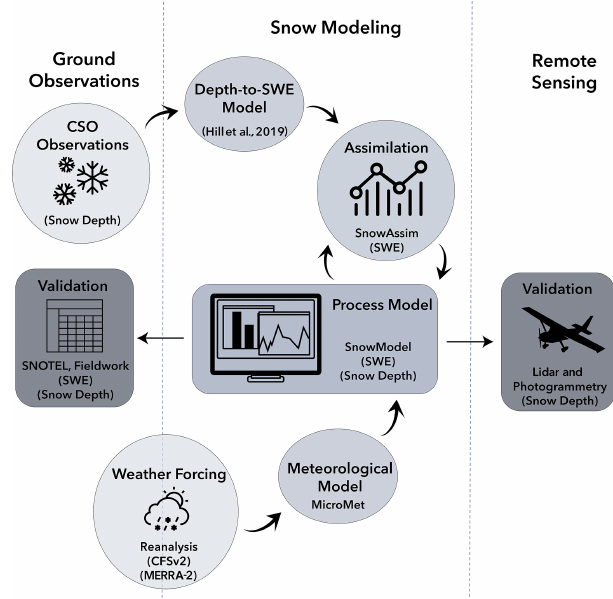
Figure 2. Model dataflow diagram. The model chain begins with the weather forcing product and the CSO data sets. The arrows indicate dataflow through the series of submodels to the process model out- put. The model output is then validated by the SNOTEL station time series, the 2018 fieldwork, and the remote sensing data